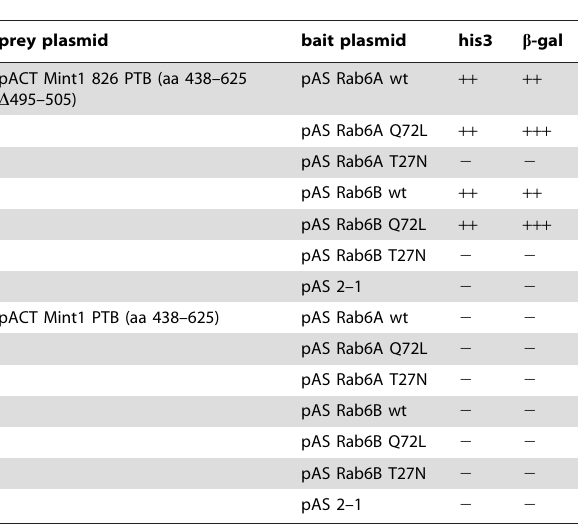
Table 4. Mapping of the Mint1 826 interacting domain.